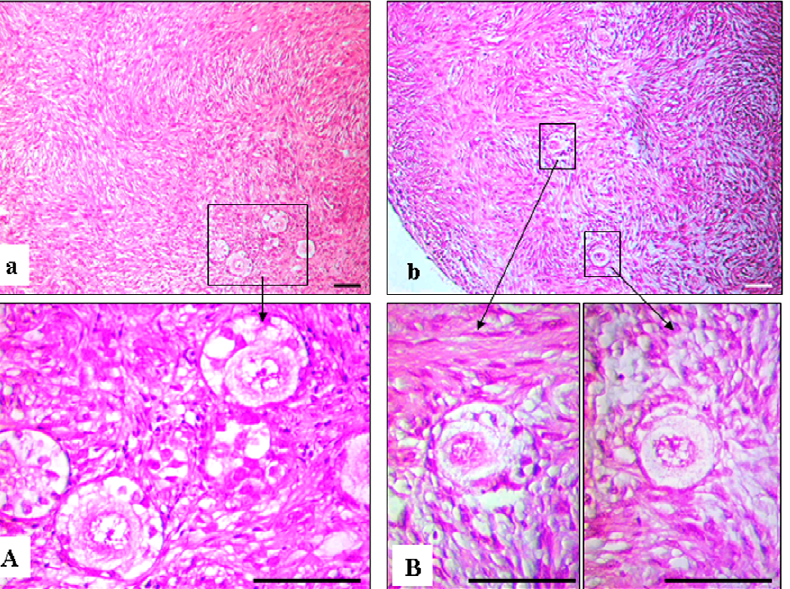
Figure 4. Histological micrographs of follicles from cryopreserved ovarian tissue after in vitro- and CAM-culture. (a, A) in vitro culture, (b, B) CAM culture. Bar=25 m m.